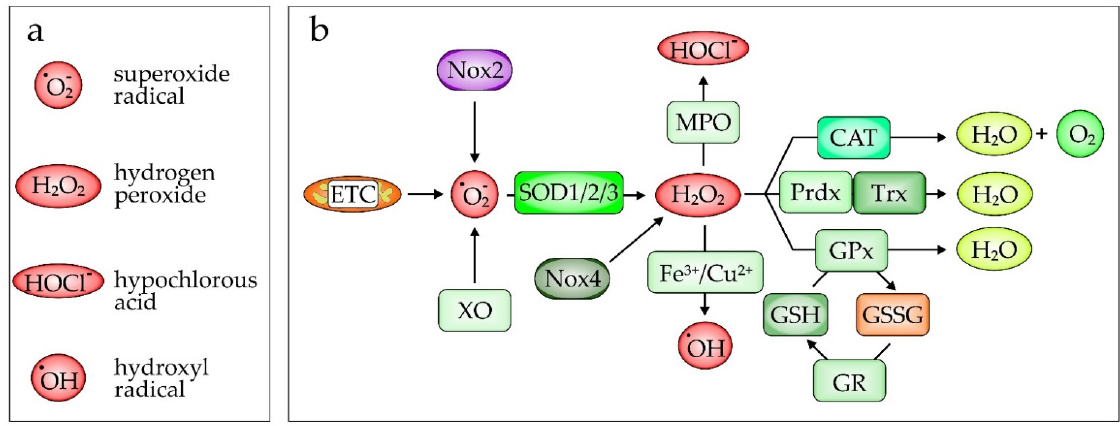
Figure 2. Reactive oxygen species (ROS) and ROS-generating and -scavenging enzymes. ( a ) ROS involved in ARDS. ( b ) The superoxide radical O 2 − is generated by the NADPH oxidase 2 (Nox2), the xanthine oxidase (XO), and the electron transfer chain (ETC) located in the mitochondria. O 2 − is dismutated to hydrogen peroxide (H 2 O 2 ) by one of three superoxide dismutases (SODs), which are located in the cytosol (SOD1 ≙ CuZnSOD), in mitochondria (SOD2 ≙ MnSOD), or extracellularly, often associated with the extracellular matrix (SOD3 ≙ EC-SOD). One further source of H 2 O 2 is Nox4, which is located in mitochondria or endoplasmic reticulum (ER) of endothelial as well as epithelial cells. H 2 O 2 is the substrate for the myeloperoxidase-(MPO)-derived oxidant hypochlorous acid (HOCl − ), known to cause tissue injury. Stored in neutrophil granules, MPO is released following neutrophil activation. In the Fenton reaction, H 2 O 2 is further metabolized to the highly antimicrobial hydroxyl radical ( ˙ OH). ROS-scavenging enzymes, such as catalase (CAT) or glutathione peroxidase (GPx), detoxify H 2 O 2 to H 2 O and O 2 . To achieve this, GPx oxidizes GSH to GSSG, which in return is reduced via the glutathione reductase to GSH. Similarly, peroxiredoxin (Prx), belonging to a small family of peroxidases, reduces H 2 O 2 by oxidizing thioredoxin (Trx), which then is restored to the reduced form by the thioredoxin reductase (not shown).